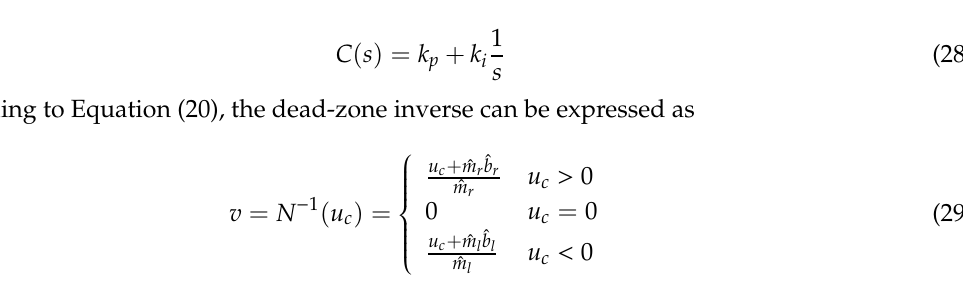
Figure 5. Control block diagram of model reference adaptive dead-zone inverse control.